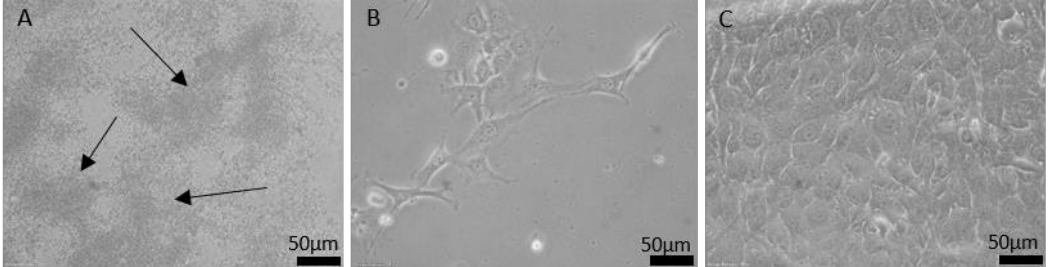
Figure 3. Light microscopic images of cell growth in petri dish after 24 h incubation with ( A ) UV-sterilized, ( B ) ethanol-sterilized and ( C ) steam-sterilized galinstan–silicone rubber sample. In ( A ) mostly bacteria clouds are visible. Image ( B ) shows a low number of fibroblast cells as well as necrotic cells. Image ( C ) shows a confluent fibroblast layer.